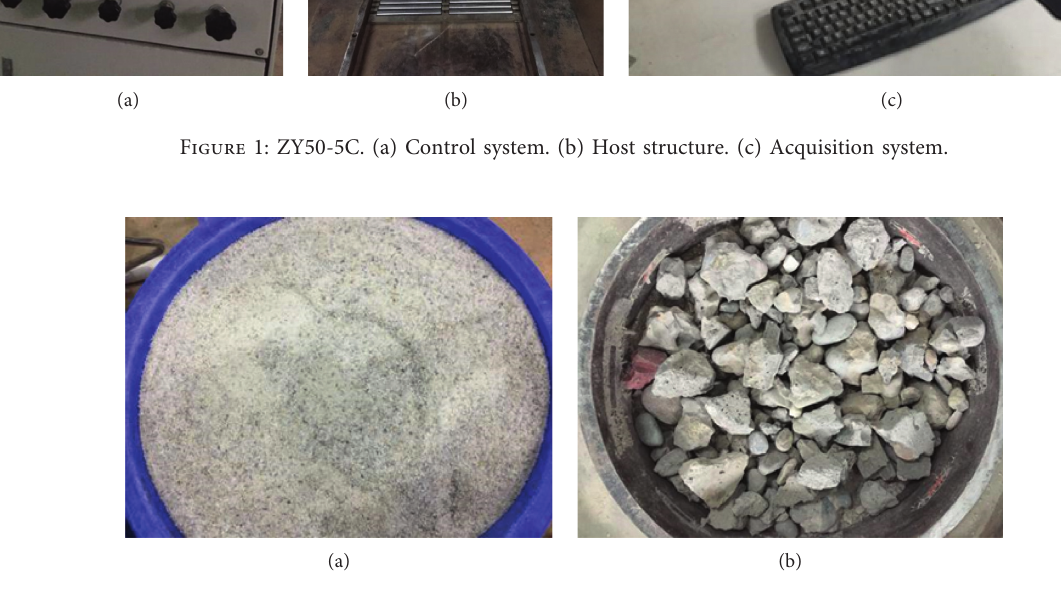
Figure 2: S-RMs filler. (a) Quartz sand. (b) Mixture of sand pebbles and concrete blocks. Table 1: Grading of S-RMs specimens (unit: %). Particle diameter d